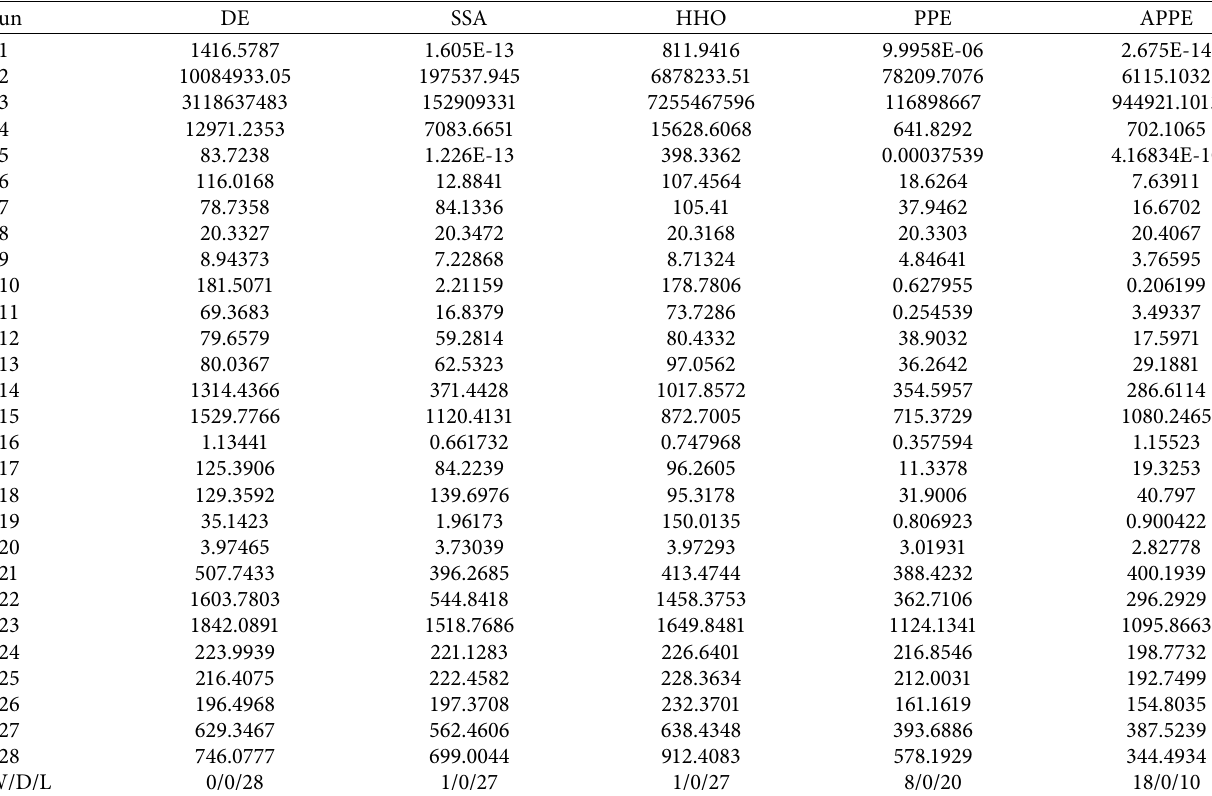
Table 3: Comparison of the mean result of 51 runs on 10D in 28 benchmark functions.